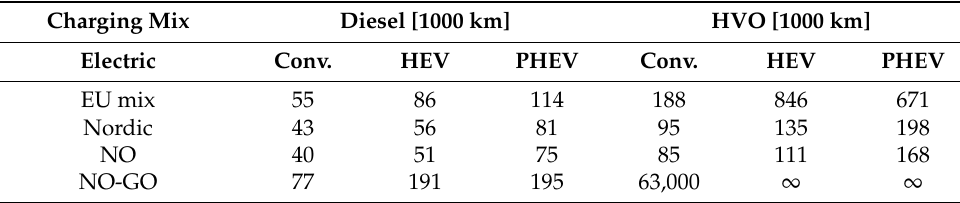
Table 6. Carbon payback time for the electric bus